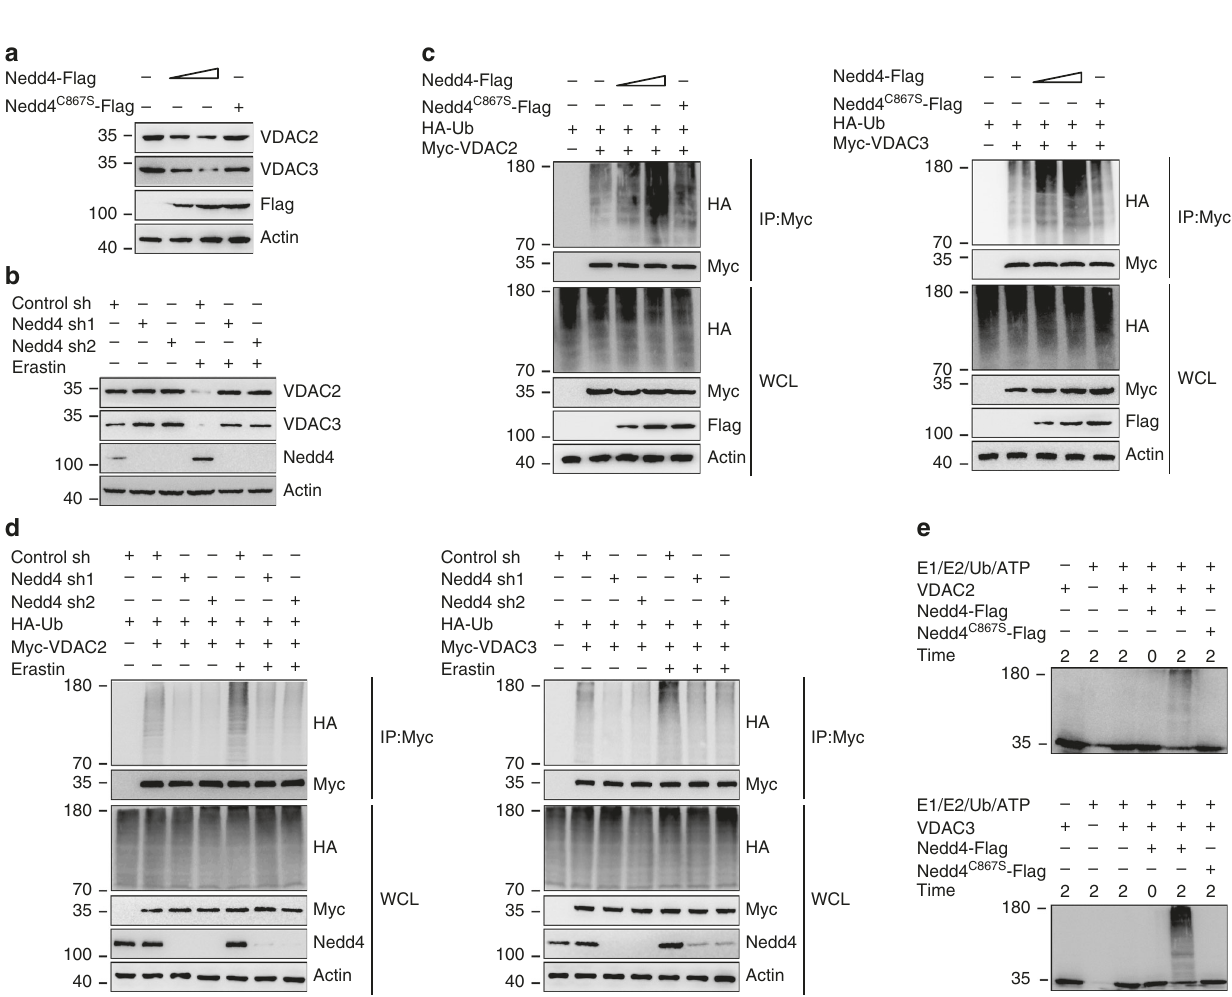
Fig. 3 Nedd4 negatively regulates VDAC2/3 stability as the speci fi c E3 ubiquitin ligase. a Nedd4 decreased VDAC2/3 protein in a dose-dependent manner. A375 cells were transfected with Flag-Nedd4 (0, 1.5, and 6 µ g) or Flag-Nedd4 C867S (6 µ g). The protein expression level of VDAC2/3 was assayed by western blot. Nedd4 WT can destabilize VDAC2/3, but Nedd4 C867S cannot affect the stability of VDAC2/3. b Knockdown of Nedd4 stabilizes VDAC2/ 3. A375 cells were transfected with control shRNA or Nedd4 shRNAs for 36 h, then treated with DMSO or Erastin (5 µ M) for 12 h. The protein levels of VDAC2, VDAC3, and Nedd4 were analyzed by western blot. c Nedd4 ubiquitylates VDAC2/3 in vivo. A375 cells were transfected with indicated DNA constructs for 48 h and treated with MG132 (50 mM) for 4 h before harvest. Cell lysates were immunoprecipitated with anti-Myc and analyzed by immunoblotting with indicated antibodies. d Knockdown of Nedd4 reduced the ubiquitination of VDAC2/3 in vivo. A375 cells were transfected with indicated DNA constructs for 36 h, then treated with DMSO or erastin (5 µ M) for 8 h. Before cell harvest, MG132 (50 mM) was added into the medium for 4 h. Cell lysates were immunoprecipitated with anti-Myc and analyzed by immunoblotting with indicated antibodies. e Nedd4 ubiquitylates VDAC2/3 in vitro. Puri fi ed VDAC2 and VDAC3 proteins were ubiquitylated in the presence of puri fi ed Nedd4 in vitro. See “ Methods ” for further details. After in vitro ubiquitylation reaction, samples were analyzed by immunoblotting with anti-VDAC2 and anti-VDAC3